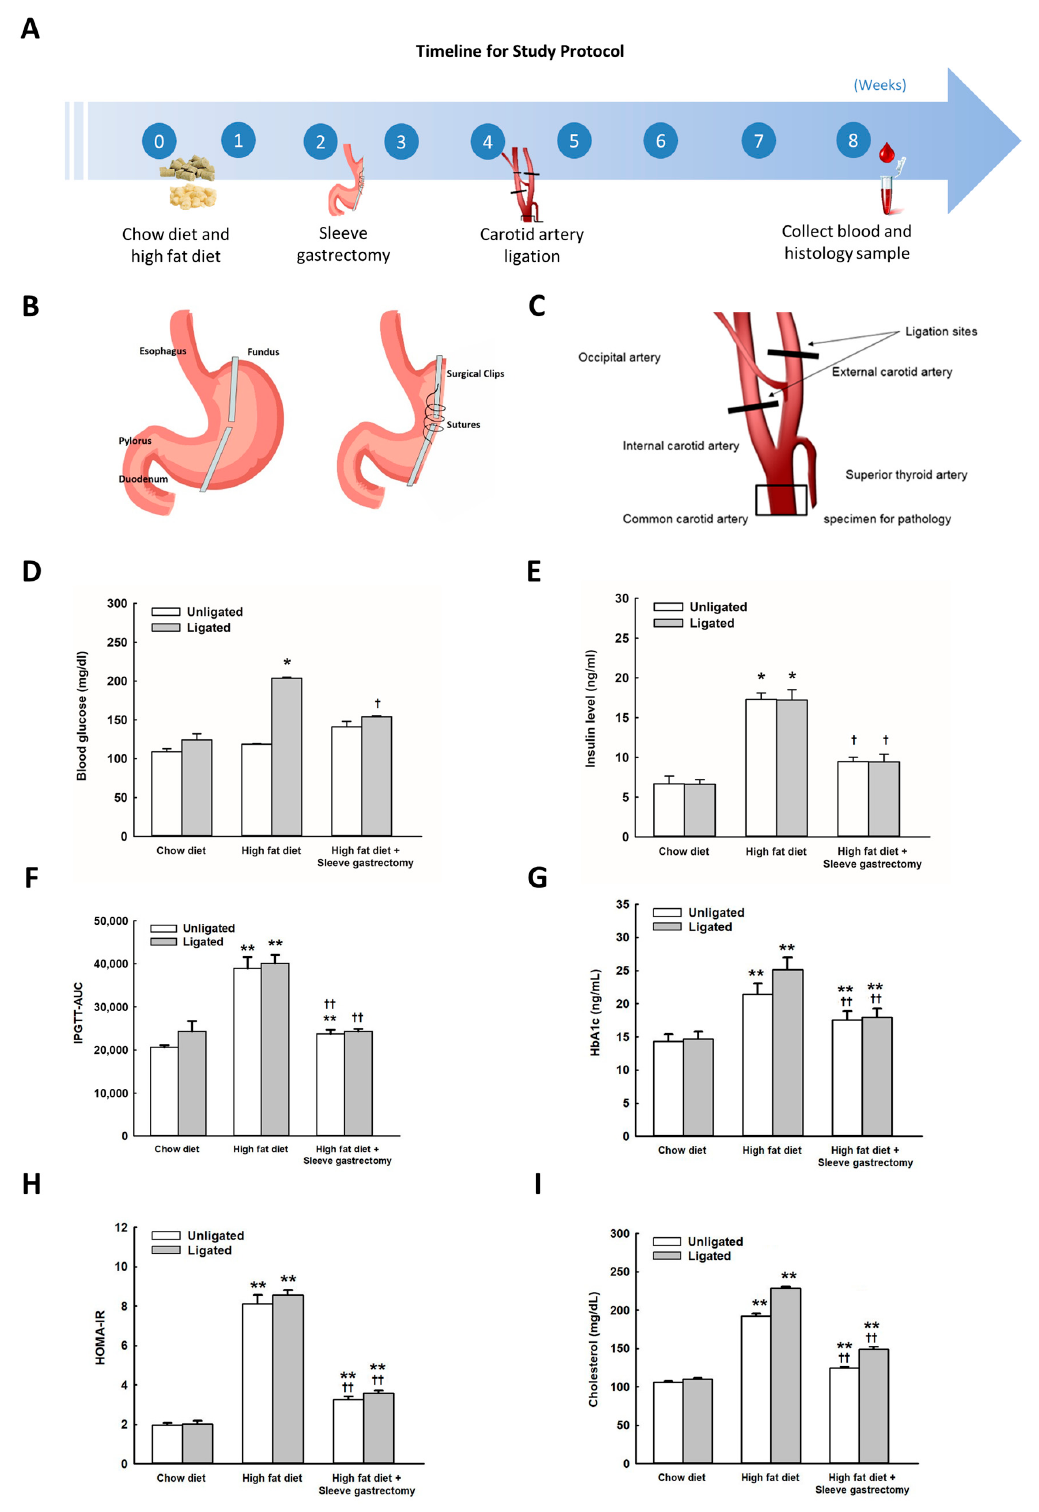
Figure 1. Effects of SG on glucose and cholesterol metabolism in HFD-fed mice. Timeline for the experimental procedures, blood sampling, and tissue processing during the study ( A ). The SG and carotid artery ligation procedures are illustrated in ( B , C ). Changes of glucose, insulin, and homeostatic assessment model for insulin resistance (HOMI-IR) were assessed ( D – H ). The cholesterol level in mice increased significantly after HFD and decreased significantly after SG ( I